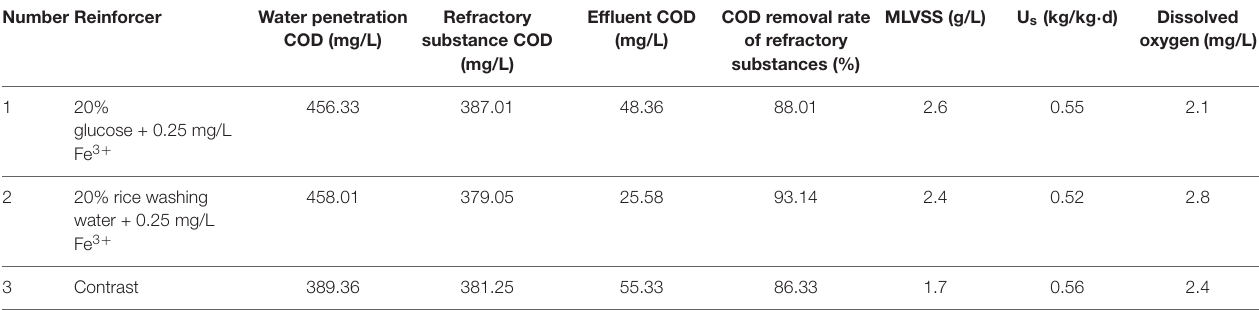
FIGURE 6 | Change curve of COD removal rate of control system. TABLE 1 | Operation of simulated waste water treatment by biological